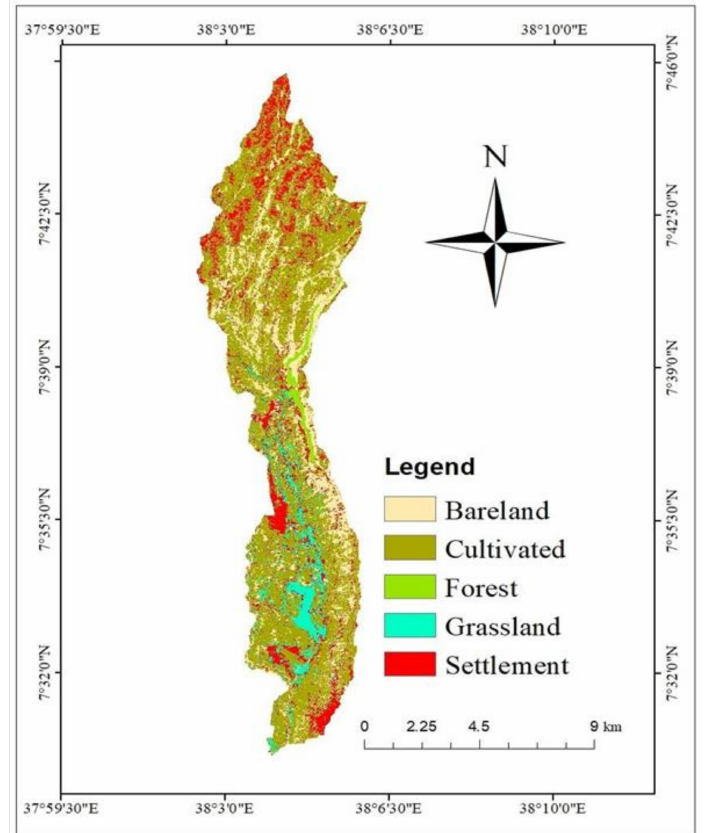
Figure 8. The LULC Map of Matenchose watershed in